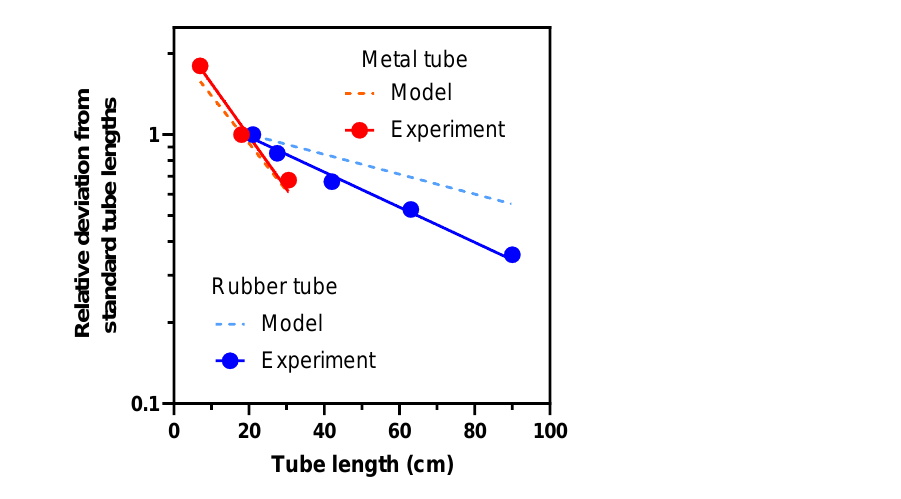
Figure 4. The relative alkali transmission through tubes connecting the TGA and the SID as a function of tube length: metal tube (red symbols and line) and rubber tube (blue symbols and line). Results obtained using a model for particle penetration through tubes [24] are included for the metal (orange dashed line) and rubber tube (light blue dashed line) cases.